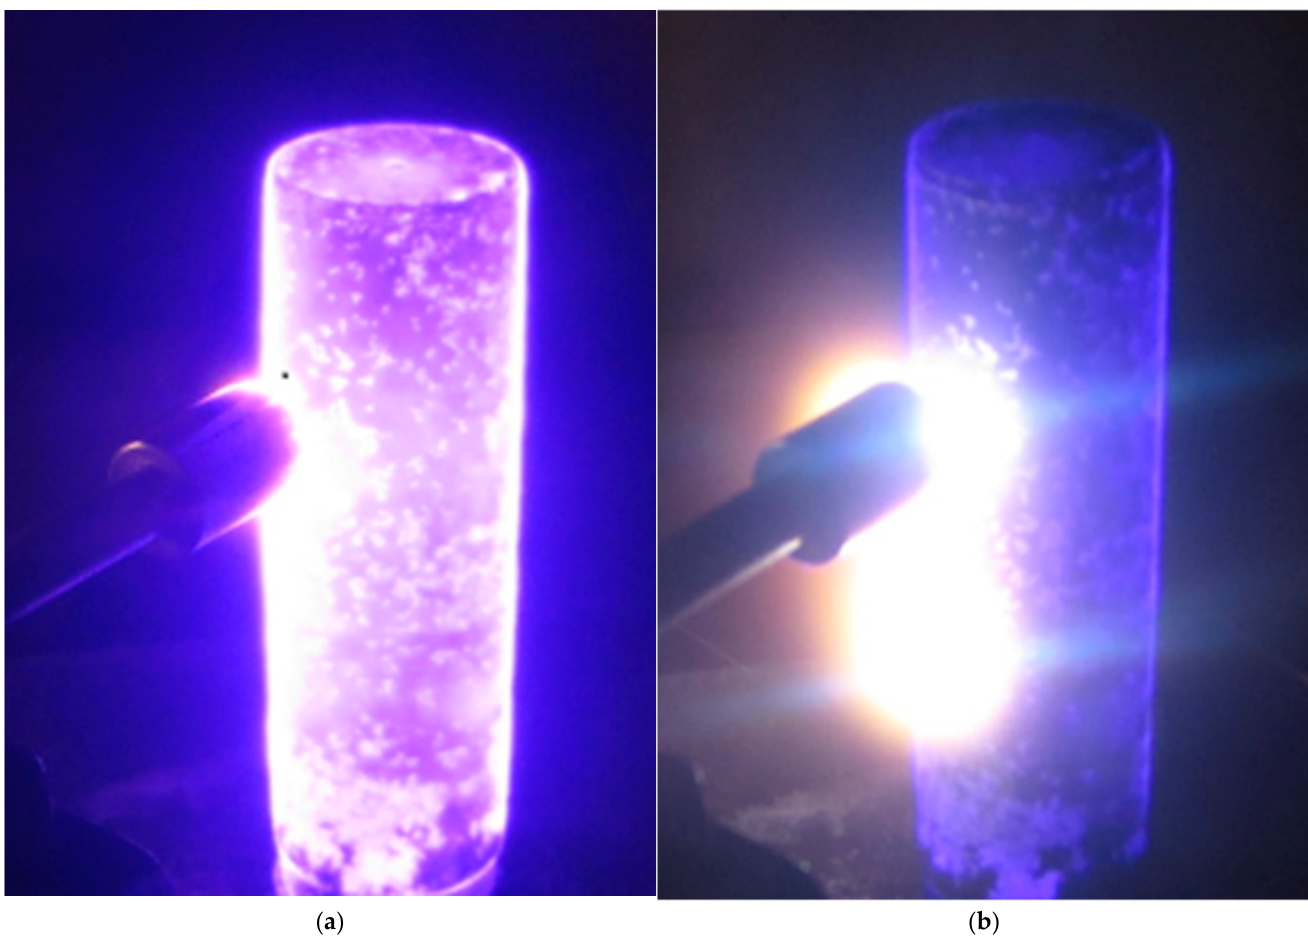
Figure 1. The view of the glow discharge on the cathode surface in stable ( a ) and unstable ( b ) burning modes during the ion treatment (the bright spots to the right—arc breakdowns).